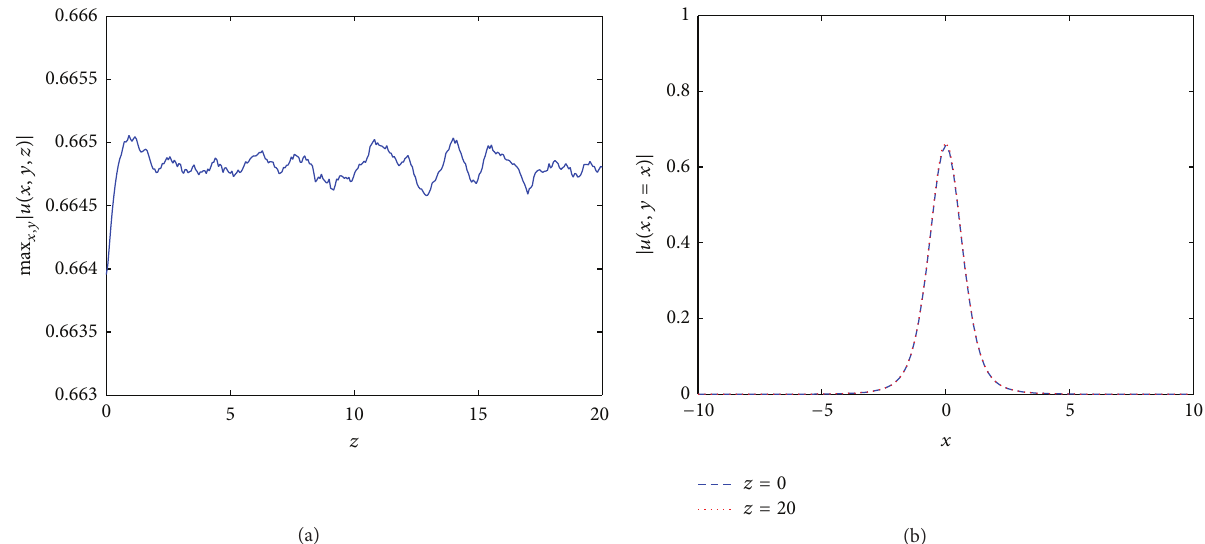
Figure 20: Nonlinear evolution of the lattice soliton situated at the Penrose potential with 𝜇 = 1.5 for the self-focusing cubic and the self- focusing quintic model. (a) Peak amplitude of the lattice soliton as a function of the propagation distance. The initial condition is taken as the lattice soliton with a 0.01 noise in the amplitude and phase; (b) cross section along the diagonal axis of the lattice soliton before and after evolutions ( 𝑧 = 0 and 𝑧 = 20